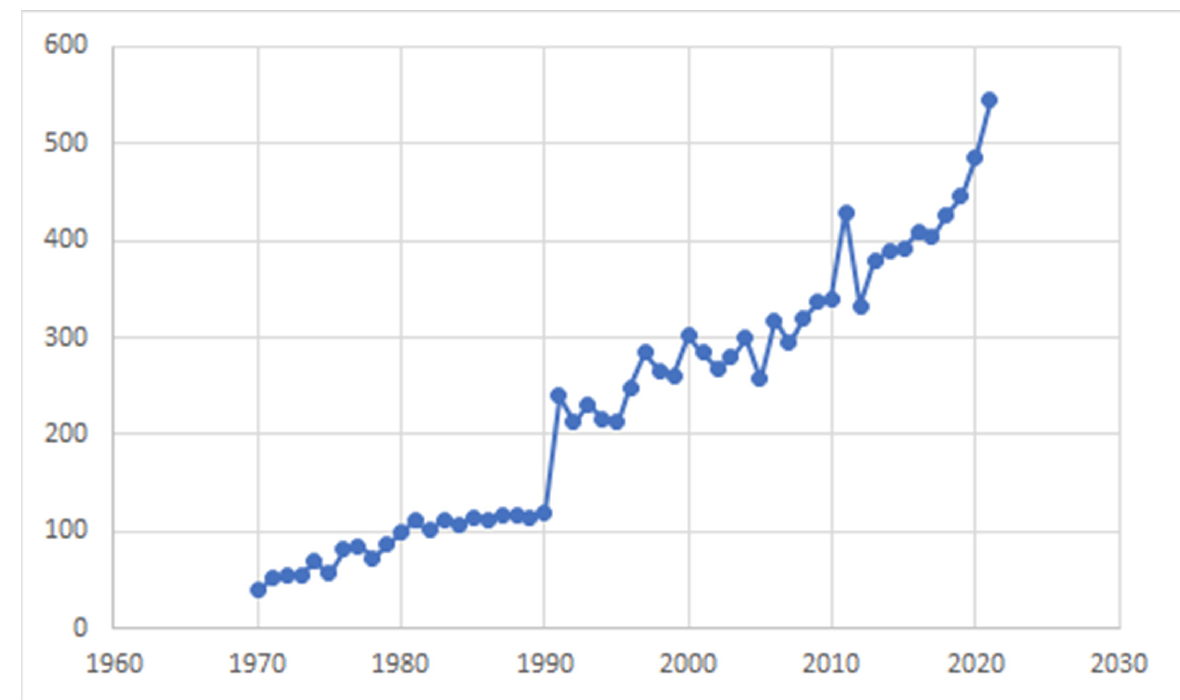
Figure 2. Production of scientific research on crayfish from 1970 to 2021.